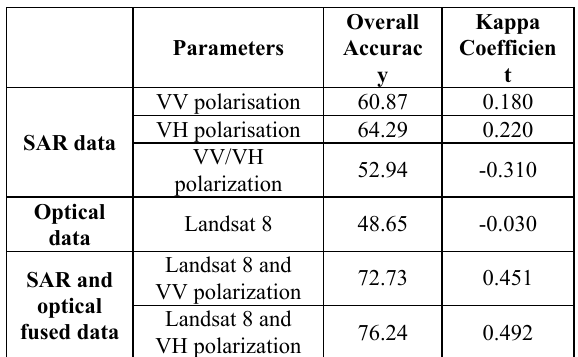
Table 2. Overall accuracy and Kappa Values for SAR and optical data